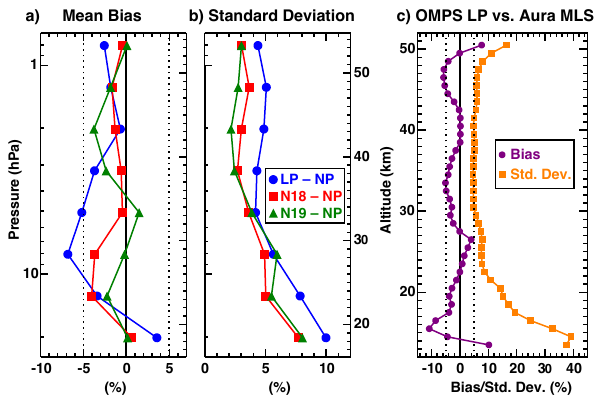
Fig. 1. Vertical profiles of the (a) mean differences and (b) corre- sponding standard deviations of the differences for OMPS LP (blue line and circles), SBUV/2 NOAA 18 (red line and squares), and SBUV/2 NOAA 19 (green line and triangles) against OMPS NP. (c) Vertical profiles of mean differences (purple line and circles) and standard deviations (orange line and squares) for comparisons between OMPS LP and Aura MLS. All data were compared over 55–82 ◦ S and September–November 2012.